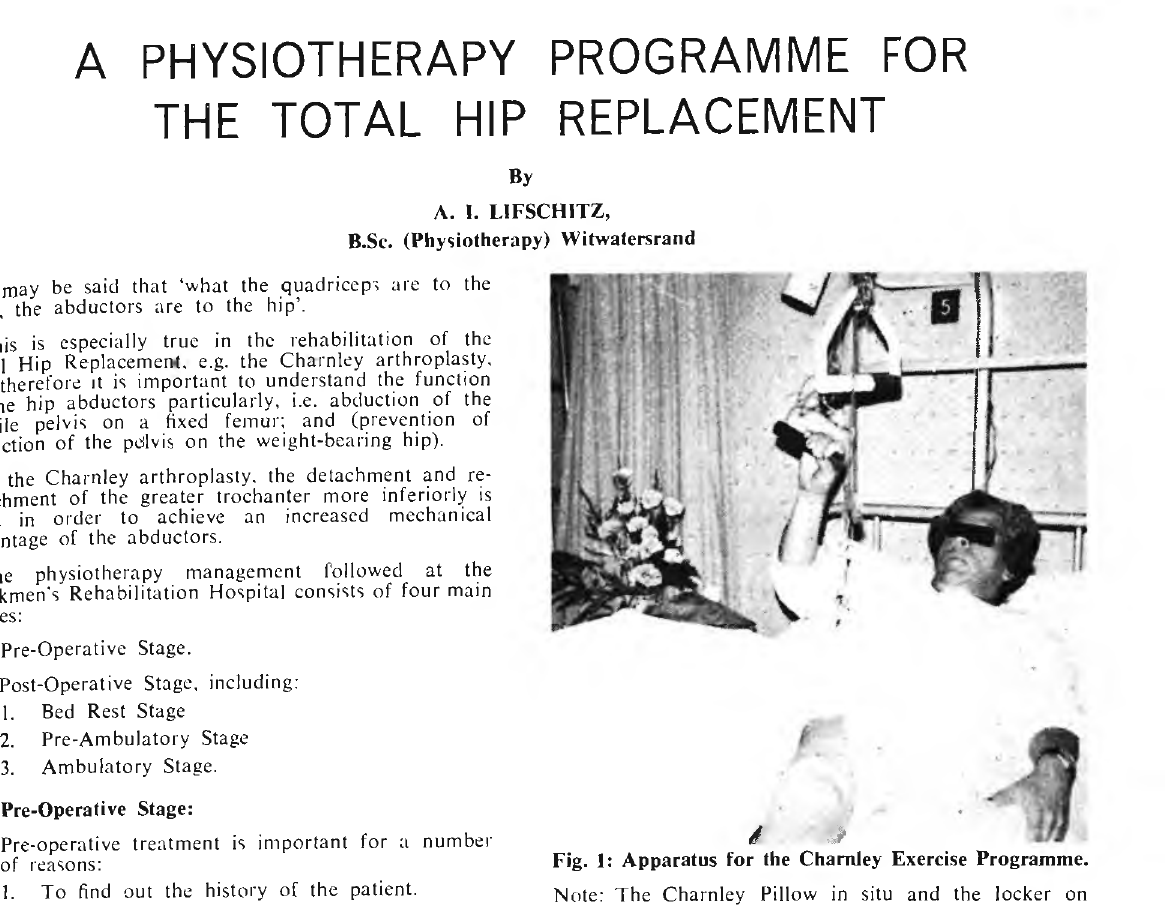
4 J> Fig. 1: Apparatus for the Charnley